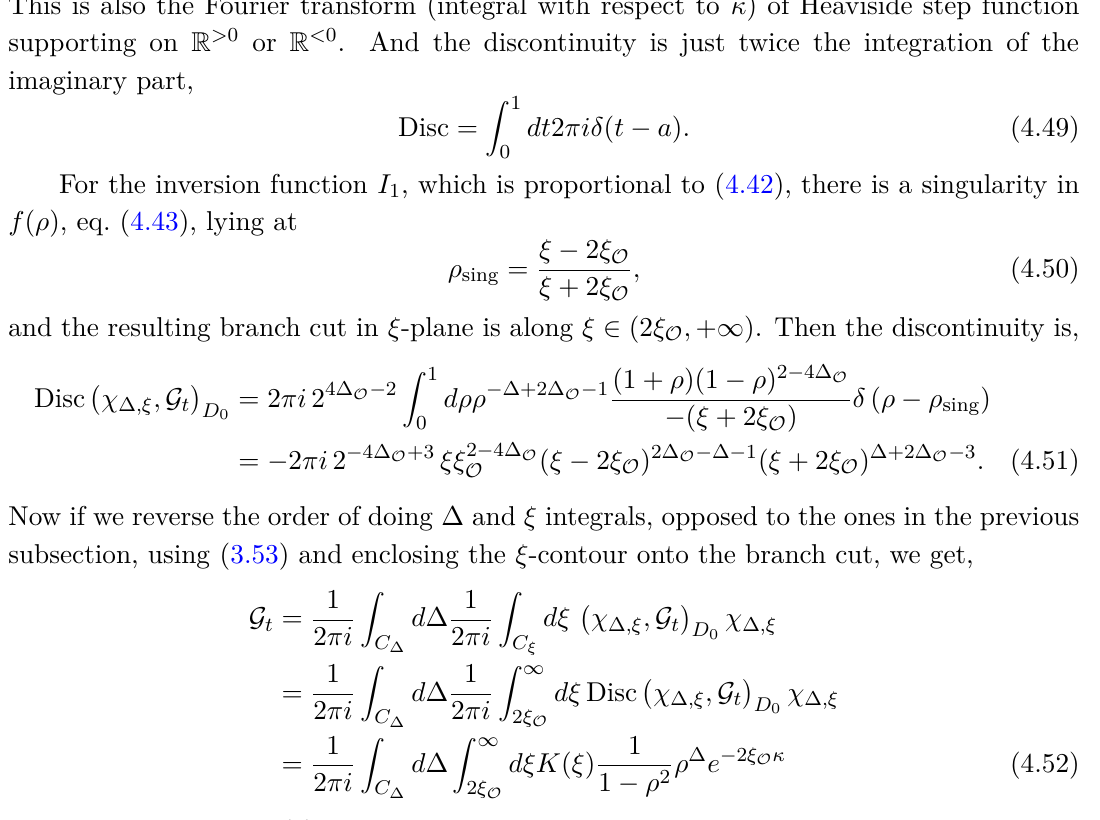
Figure 2. The analytic structure of ( χ ∆ ,ξ , G t ) from ∆ -viewpoint it has double trace multiple